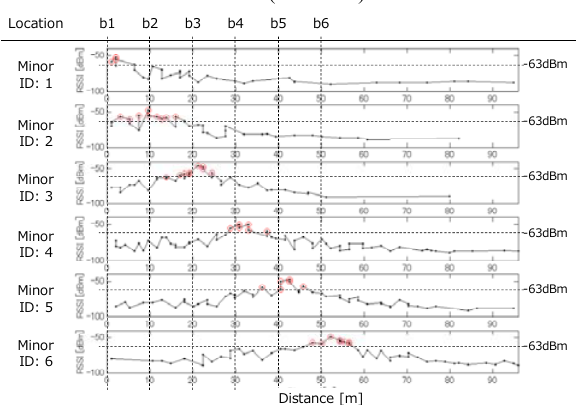
Figure 16. Measured RSS values in the second experiment